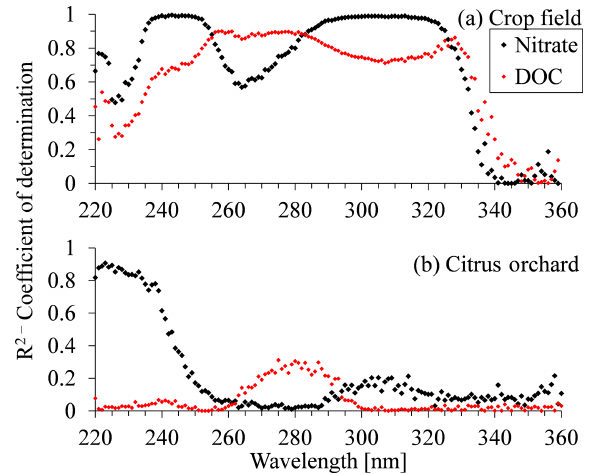
Figure 5. Coefficient of determination ( R 2 ) for nitrate and dis- solved organic carbon (DOC) plotted against wavelength in the UV region for (a) crop field station and (b) citrus